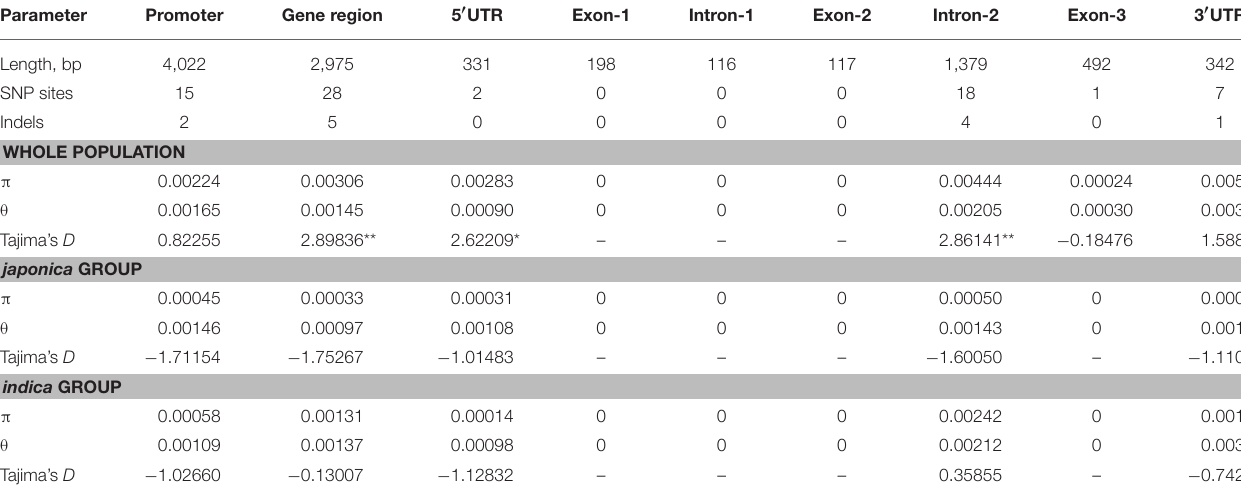
TABLE 4 | Summary of DNA polymorphic sites of OsPsbS1 genome.